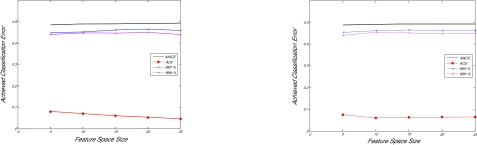
PACE analysis using a SVM-based classifier using the AUC scoring criterion, with a 0.6 MAC threshold. Left Panel: performance without peak selection. Right panel: performance with peak selection. In these figures, the upper solid line represents the Mean Achieved Classification Error (MACE) under the null hypothesis derived using sample class label permutations. The next two dotted lines represent the 95th and 99th percentile, and the lower solid line represents the ACE for the classifier (averaged over iterations).